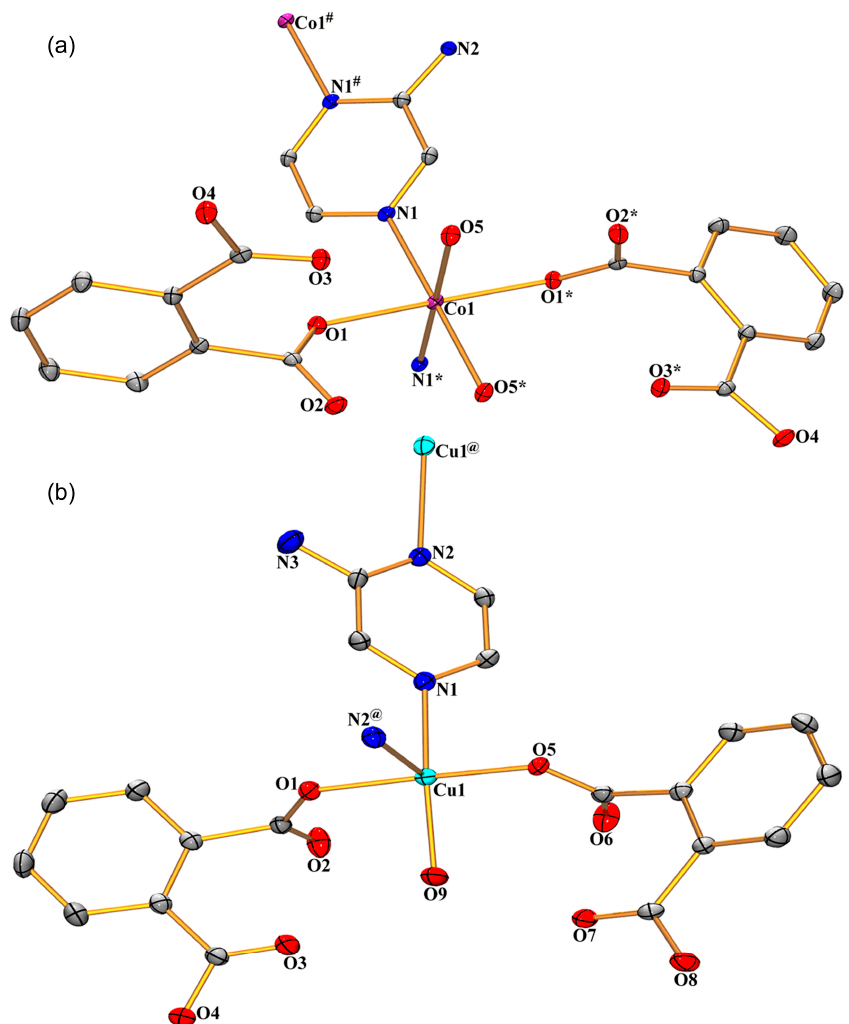
Figure 1. Central atom environments (Oak Ridge Thermal Ellipsoid Plot (ORTEP) view) and atom numbering schemes of the title polymers ( a ) 1 and ( b ) 2 . The 2-aminopyrazine moiety is disordered over an inversion centre in 1 where the amino group have partial site occupancy factor of 0.5. In 2 , the amino group of the 2-aminopyrazine moiety have 0.7 and 0.3 occupancies. Only one amino group with fractional site occupancies have been shown for both compounds. Solvent water molecule in 2 and hydrogen atoms for both structures are omitted for clarity. Thermal ellipsoids are drawn at 30% probability. Polymers 2018 , 10 , x FOR PEER REVIEW